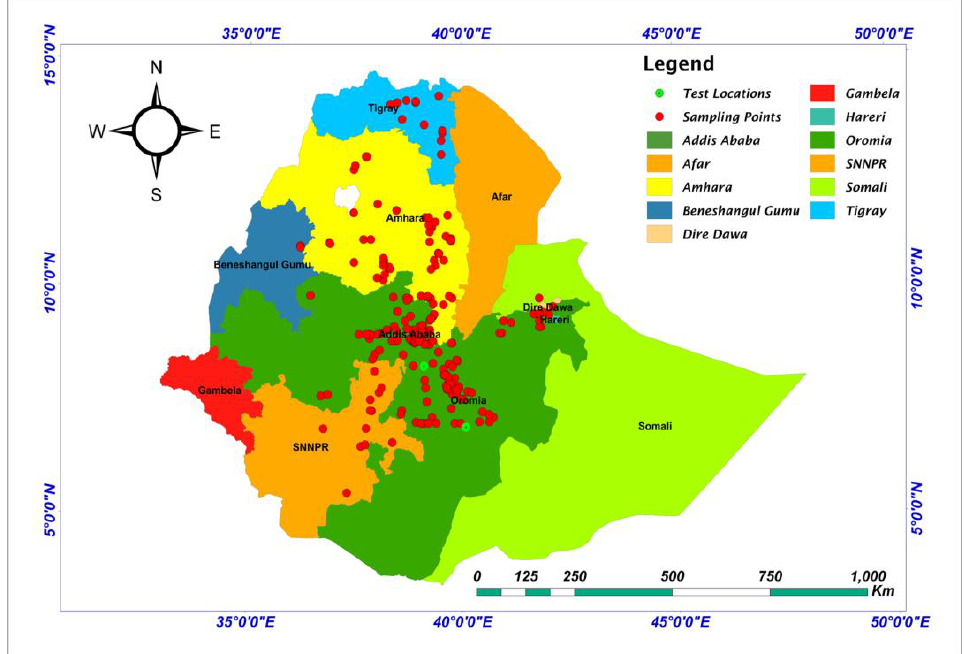
Figure 1. Map of Ethiopia showing the sample collection sites of landrace accessions and field trial sites.